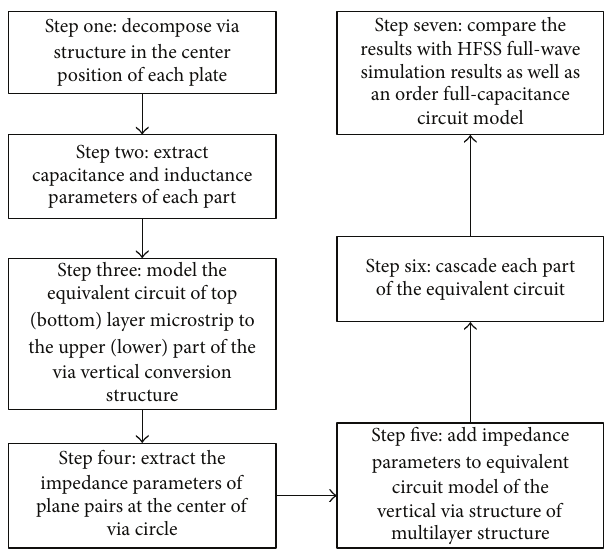
Figure 4: Flowchart of segmented via modeling method.